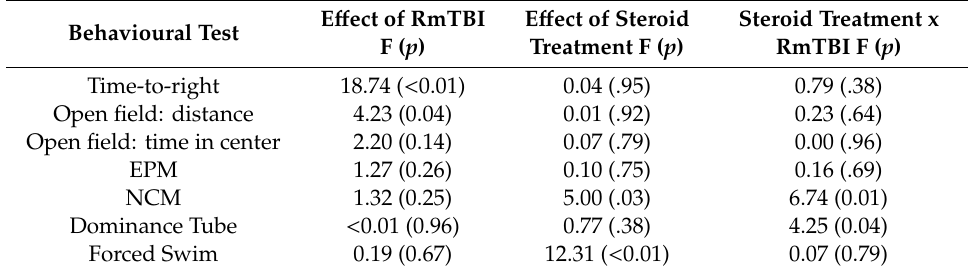
Table 2. Statistical results of the 2-way ANOVAs for the behavioural assessments following RmTBI and steroid